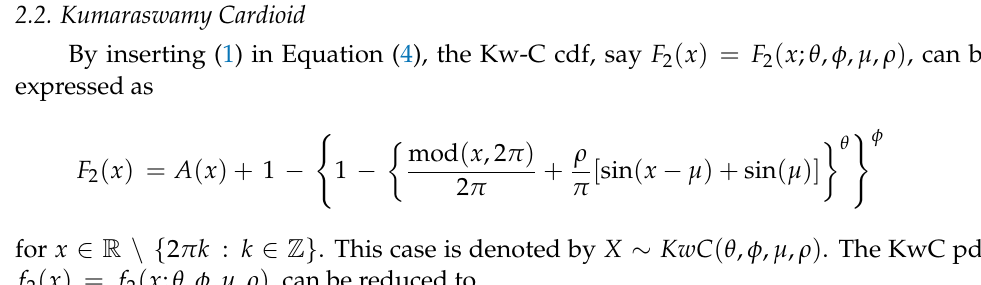
Figure 1. Cartesian and circular β C densities for some parametric